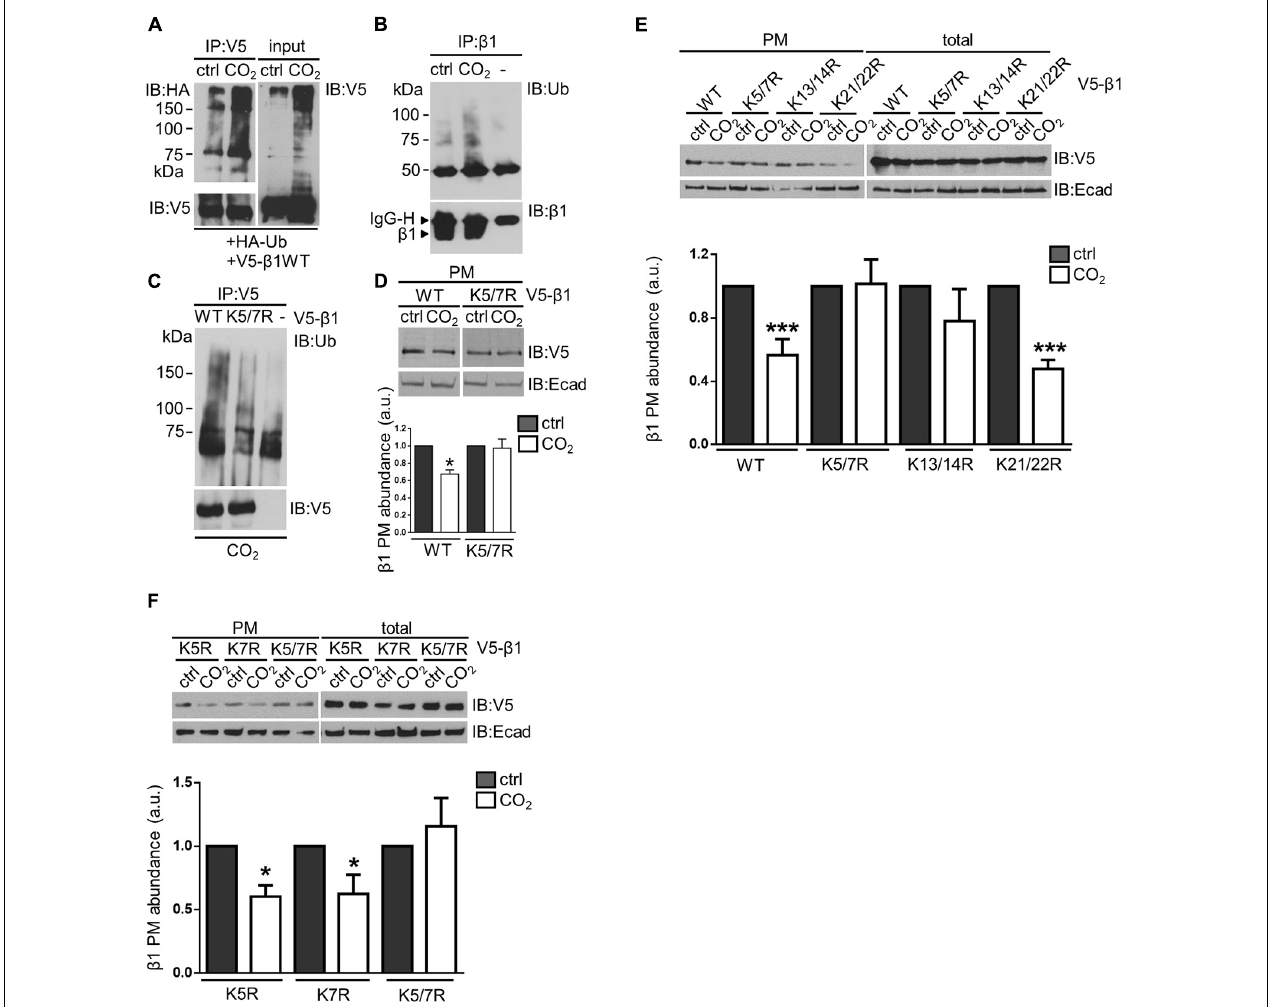
FIGURE 2 | Ubiquitination of the Na,K-ATPase β -subunit acts as a signal for endocytosis of the protein at elevated CO 2 levels in alveolar epithelial cells. (A) A549 cells were co-transfected with HA-ubiquitin (Ha-Ub) and V5- β 1 wt. 18 h after transfection, cells were exposed to 40 or 110 mmHg CO 2 at a pH of 7.4 for 15 min in the presence of MG-132. V5- β 1 wt was immunoprecipitated with anti-V5 polyclonal antibody (IP) and ubiquitinated forms were detected with an anti-HA monoclonal antibody by IB. Loading was controlled with anti-V5 monoclonal antibody. Na,K-ATPase β -subunit polyubiquitinated forms were also detected in input with anti-V5 monoclonal antibody by overexposing the films. (B) A549 cells were exposed to 40 or 110 mmHg CO 2 at a pH of 7.4 for 15 min. Biotin-streptavidin pull-down was performed to enrich in surface proteins. Na,K-ATPase β -subunit was IP with anti- β 1-subunit monoclonal antibody and Na,K-ATPase β -subunit polyubiquitinated forms were detected with anti-ubiquitin monoclonal antibody by IB. (C) A549 cells were transfected with V5- β 1 wt, V5- β 1 K5/7R or empty plasmid. Cells were exposed to 40 or 110 mmHg CO 2 at a pH of 7.4 for 15 min. V5- β 1 wt or K5/7R were IP with anti-V5 polyclonal antibody and ubiquitinated forms were detected with anti-ubiquitin monoclonal antibody by IB. Loadings were detected with anti-V5 monoclonal antibody. (D) A549 cells were transfected with V5- β 1 wt or V5- β 1 K5/7R. Cells were exposed to 40 or 110 mmHg CO 2 at a pH of 7.4 for 30 min. Biotin-streptavidin pull-downs were performed and V5- β 1 wt or V5- β 1 K5/7R abundance was analyzed by IB. Mean ± SEM, n = 3, paired t -test, * p < 0.05. (E) A549 cells were transfected with V5- β 1 wt, V5- β 1 K5/7R, V5- β 1 K13/14R, V5- β 1 K21/22R. Cells were exposed to 40 or 110 mmHg CO 2 at a pH of 7.4 for 30 min. Biotin-streptavidin pull-downs were performed and V5- β 1 abundance was analyzed by IB. (F) A549 cells were transfected with V5- β 1 K5R, V5- β 1 K7R or V5- β 1 K5/7R. Cells were exposed to 40 or 110 mmHg CO 2 at a pH of 7.4 for 30 min. Biotin-streptavidin pull-downs were performed and V5- β 1 abundance was analyzed by